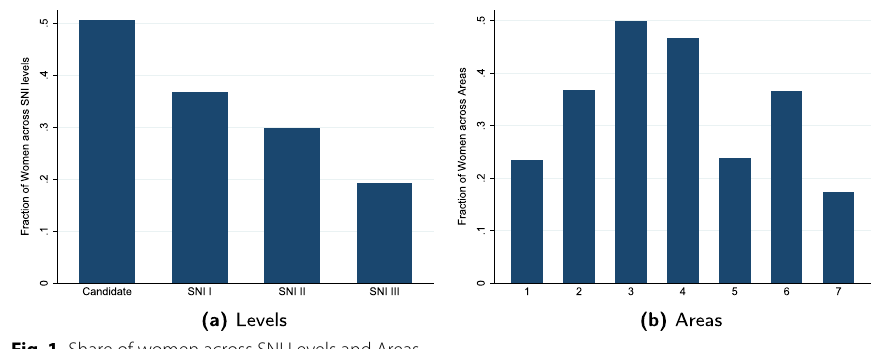
Fig. 1 Share of women across SNI Levels and